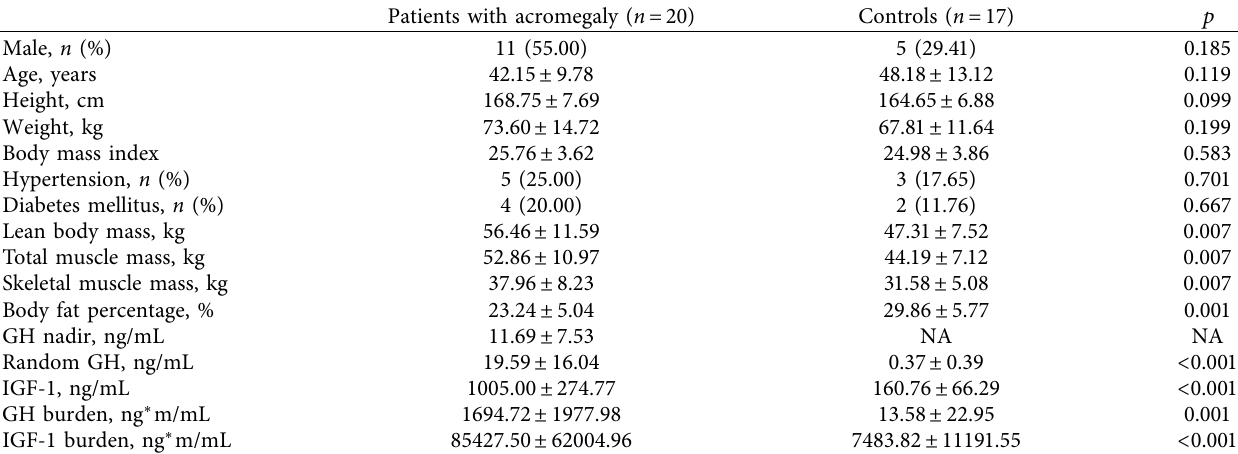
Table 1: Clinical characteristics, body composition, and hormone levels of patients with acromegaly and controls. Patients with acromegaly ( n � 20)